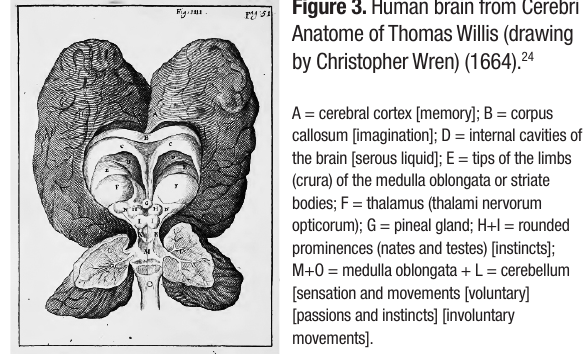
Figure 3. Human brain from Cerebri Anatome of Thomas Willis (drawing by Christopher Wren) (1664).